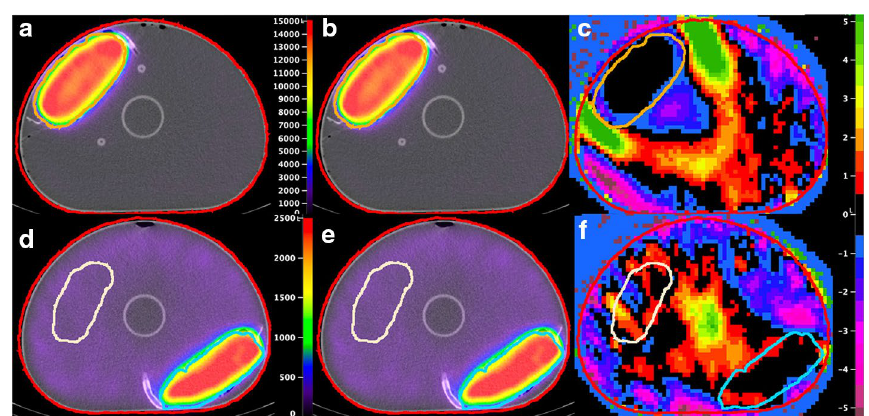
Fig. 4 Selected transaxial fusion slices of the phantom (9.34 GBq, average DTCF DTCM1 ( a and d ) and DTCM3 ( b and e , colour scale in counts), and parametric images of their relative count differences ( c and f , colour scale in per cent). VOIs: whole phantom (red), large saline bag ( a , b and c , orange), small saline bag ( d , e and f , cyan) background ( d , e and f , white). Of note, the peripheral hot objects mimicking target tissues exhibited minimal count differences (mostly black voxels,